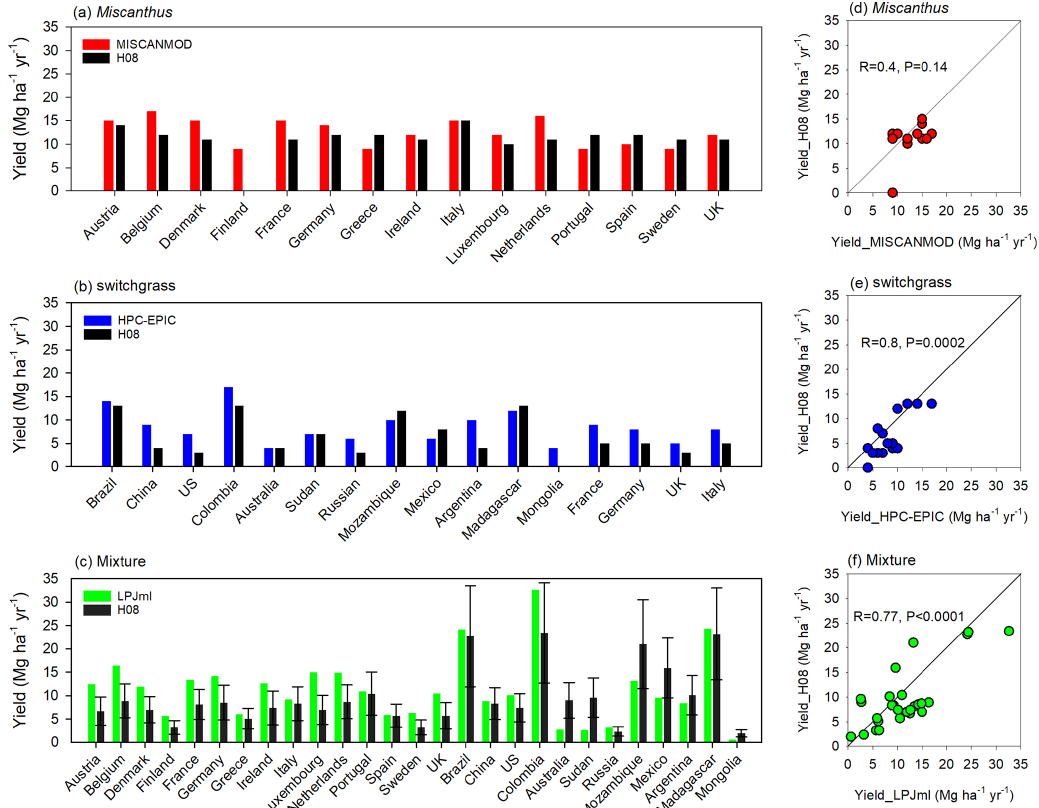
Figure 7. An independent country-specific comparison of the yield simulated by the enhanced H08 model with those of three other models (MISCANMOD, HPC-EPIC, and LPJmL) for Miscanthus (a, d) , switchgrass (b, e) , and their combination (c, f) . The H08 in (c, f) indicates the average yield of Miscanthus and switchgrass, and the upper and lower error bars in (c) represent the yields for Miscanthus and switchgrass,